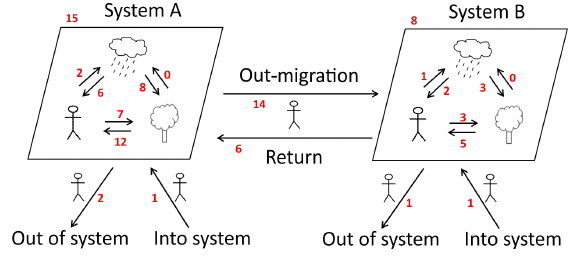
Figure 3 gives an overview of the framework’s elements considered within the reviewed ABMs by counting the occurrences of the framework’s elements. Hereby, framework elements are the interlinkages between the environmental factors and the agents, the various migration flows, as well as the origin and destination system. Fig. 3 . Conceptual diagram with the numbers beside the lines indicating the number of agent-based models considering the respective element; the tree represents the availability of natural resources, the rain cloud represents the influencing environmental factors, and the stick man represents the human